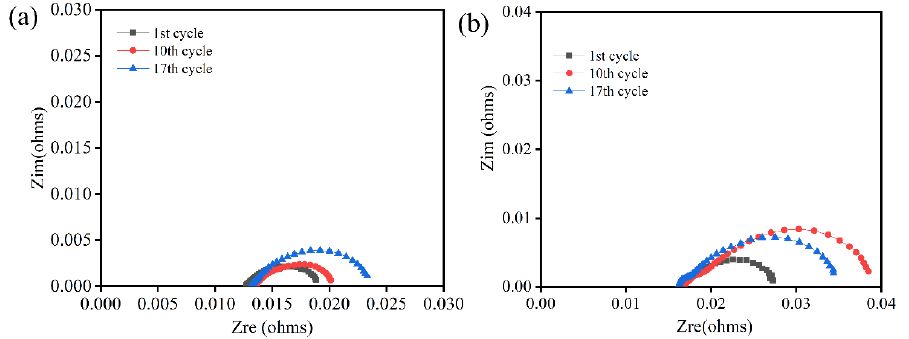
◦ C at SOEC mode ( a ) and SOFC mode ( b ) under Figure 8. EIS of single cell stack at 750 °C at SOEC mode ( a ) and SOFC mode ( b ) under various. Figure 8. EIS of single cell stack at 750